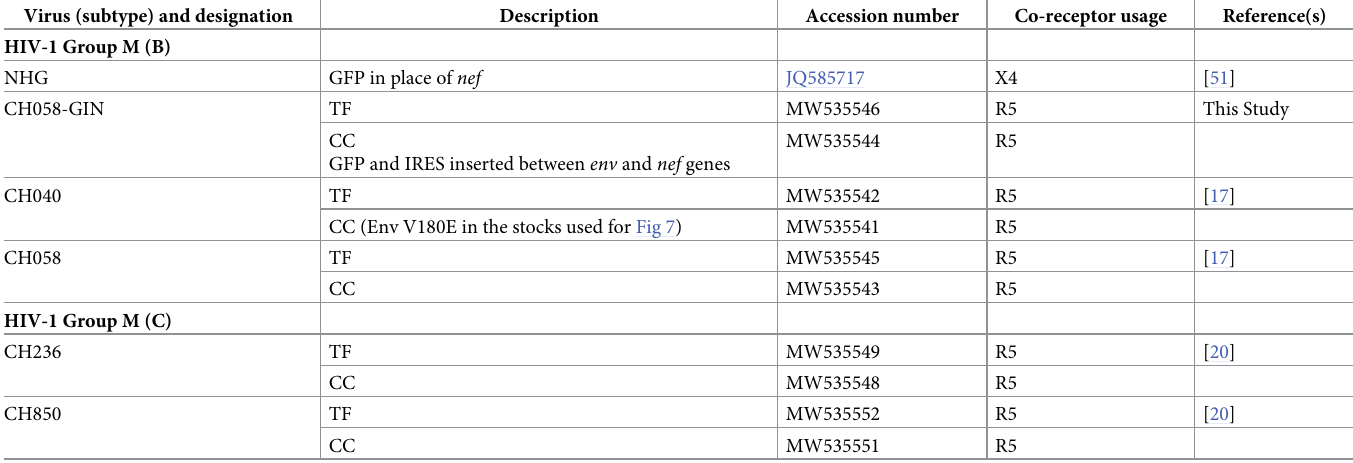
Table 1. Viruses used in this study. Virus (subtype) and